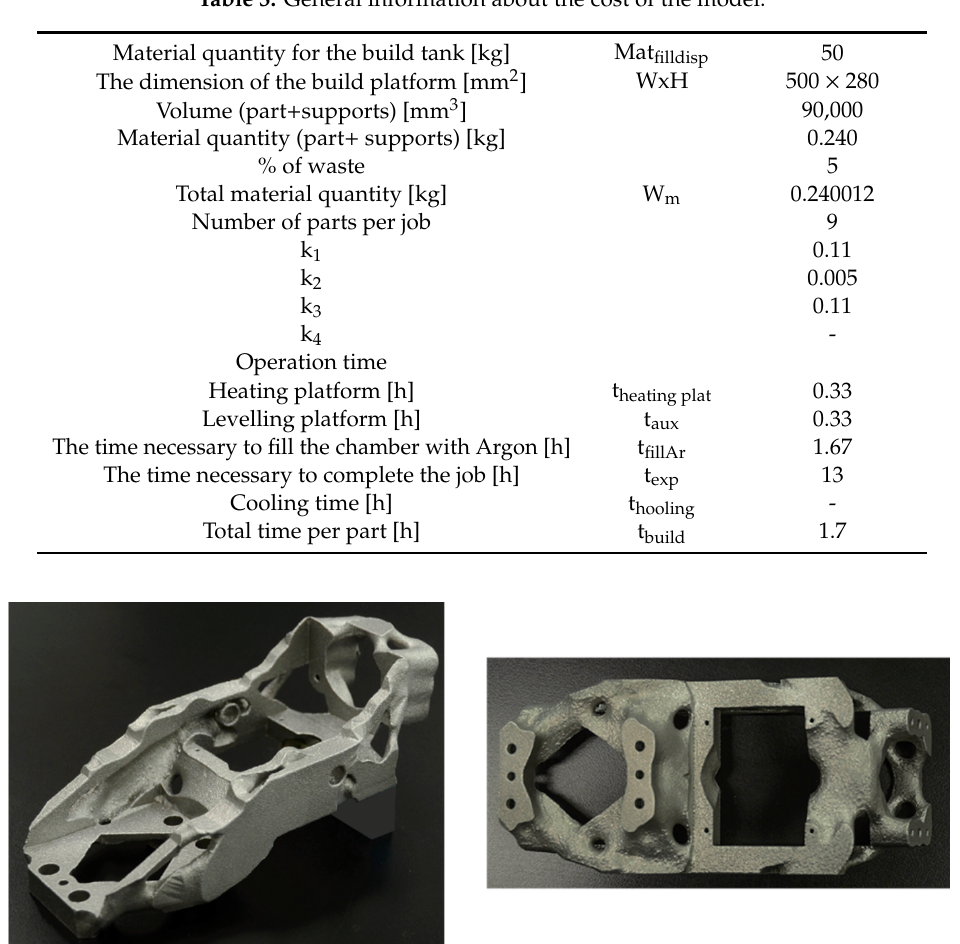
Table 3. General information about the cost of the model.